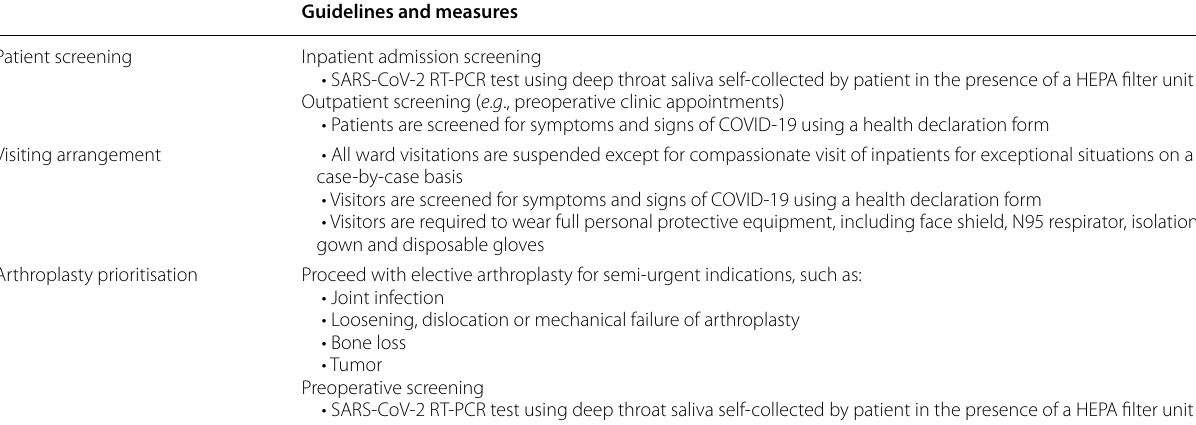
Table 2 Summary of infection control and arthroplasty service prioritization at our institution Guidelines and measures